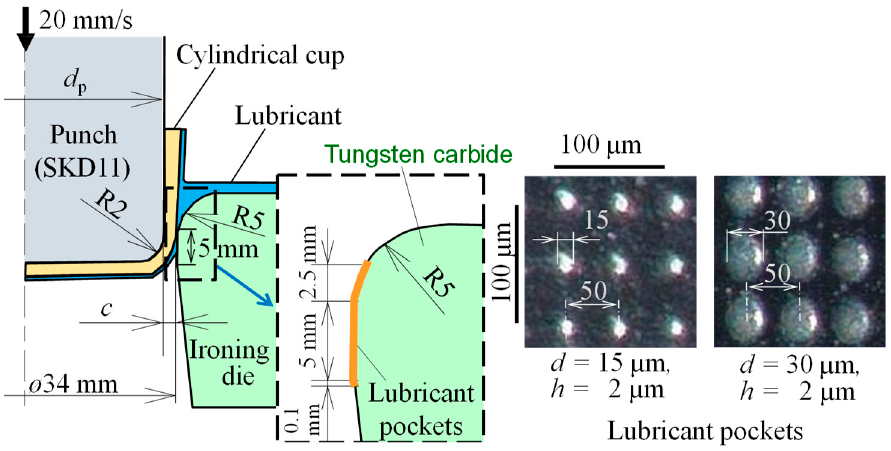
Figure 4. Ironing conditions for SUS430 stainless steel cylindrical cups and die surfaces.